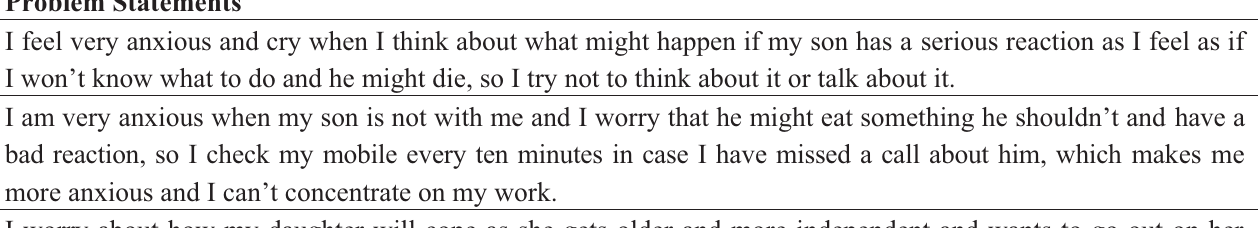
Table 2. Examples of problem statements from